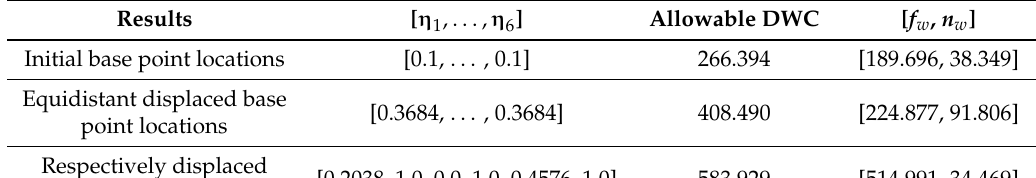
Table 2. Results for three different types of base locations.